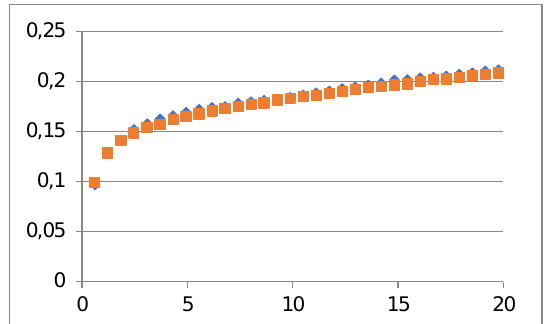
Fig. 8 Re=13000; Dependence of Velocity on the distance from active surface, which is on the position 0